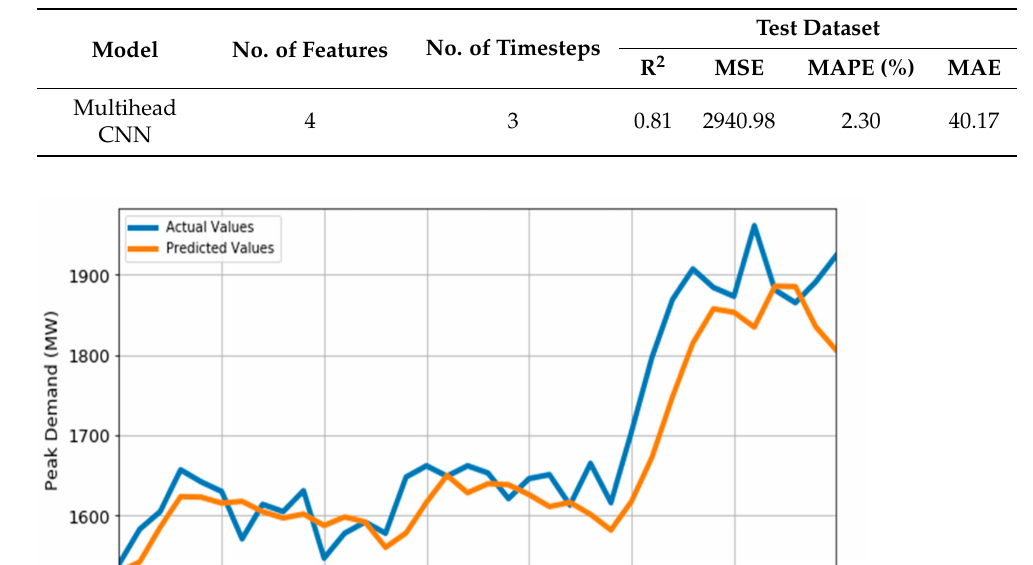
Table 10. Results of the multihead CNN model on the test set.